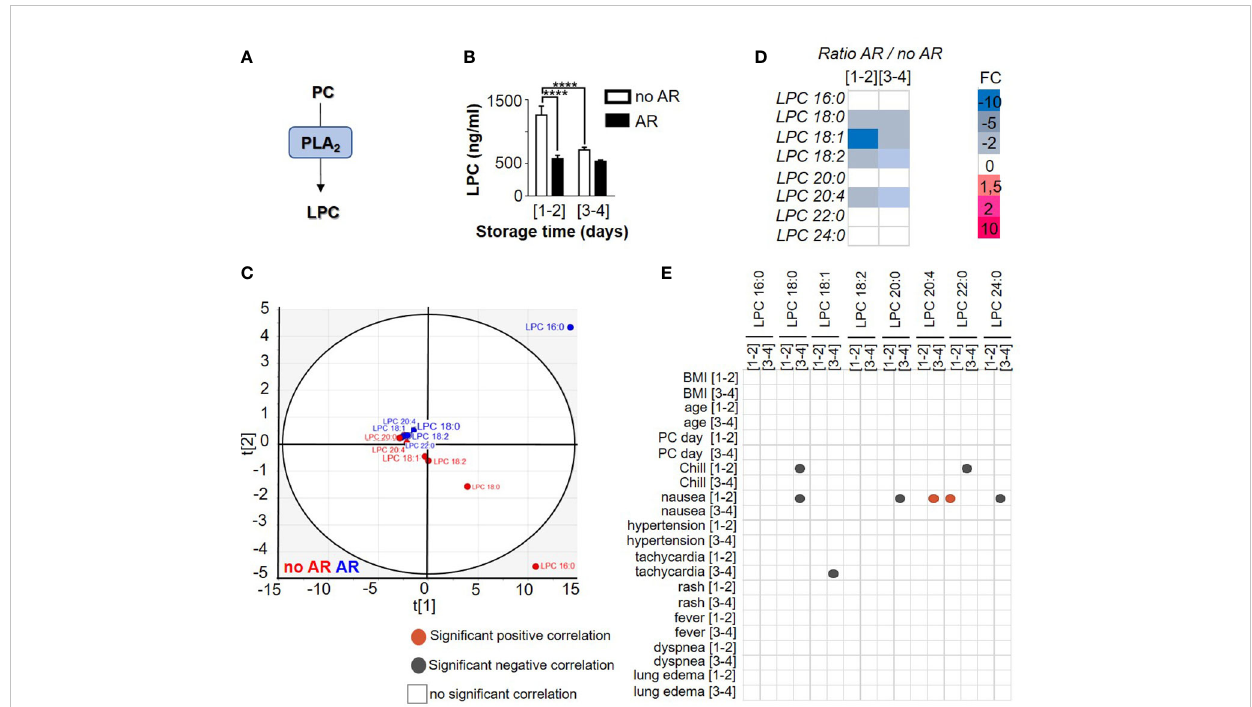
FIGURE 1 Comparison of lysophosphatidylcholine pro fi le between Single Donor Apheresis platelet concentrate with or without adverse reaction. (A) Flowchart illustrating the generation of LPC. (B) LPC generation in Single Donor Apheresis platelet concentrates (SDA-PC) with or without adverse reaction (AR). The white bar represents mean ± SEM of LPC expression without AR occurrence and the black bar denotes mean ± SEM of LPC expression with AR occurrence. (to refer to n patient, see Table 1). Statistical analysis performed with 2-way ANOVA with Tukey ’ s multiple comparisons test, p=0.0004, ****p<0.0001. (C) Two-dimensional score plot of a principal component analysis of LPC species from SDA-PC without occurrence of AR (red) and from SDA-PC with occurrence of AR (blue) taking all storage times into account. (D) Heat map represents fold change in mean LPC species expression between SDA-PC with occurrence of AR and from SDA-PC without occurrence of AR for the various storage times reported on the heat map. (E) Correlation matricx between LPC species and adverse reaction symptoms are built with a Pearson correlation. Grey dots represent a negative correlation and red dots a positive correlation, with the level of signi fi cance being p